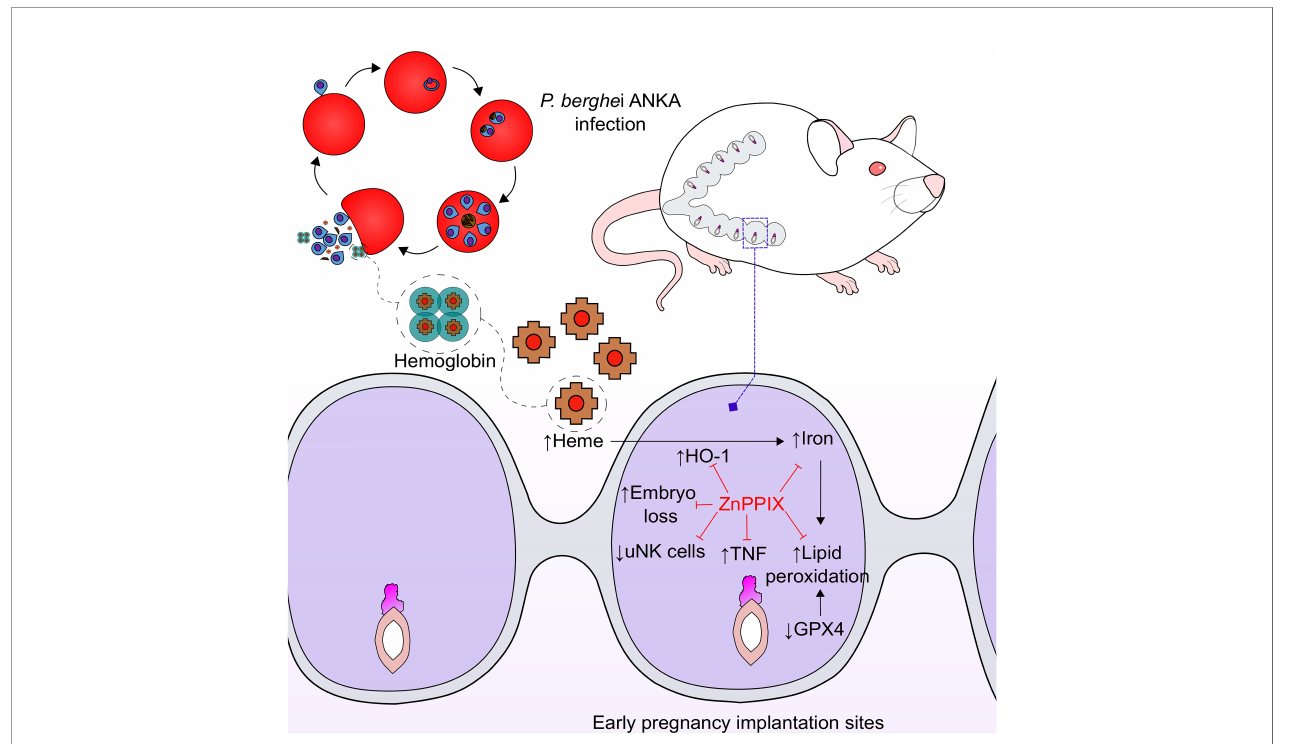
FIGURE 7 | ZnPPIX bene fi cial effects in malaria during early pregnancy. HO-1 inhibition may have several bene fi cial effects in malaria during early pregnancy. Infection causes an increase in heme levels and induction of HO-1 in implantation sites leading to iron overload, lipid peroxidation and in fl ammation that ends up in embryo loss during early pregnancy, being these alterations prevented in ZnPPIX-treated mice. Moreover, ZnPPIX treatment preserves the number of uNK cells, that decrease in infected pregnant